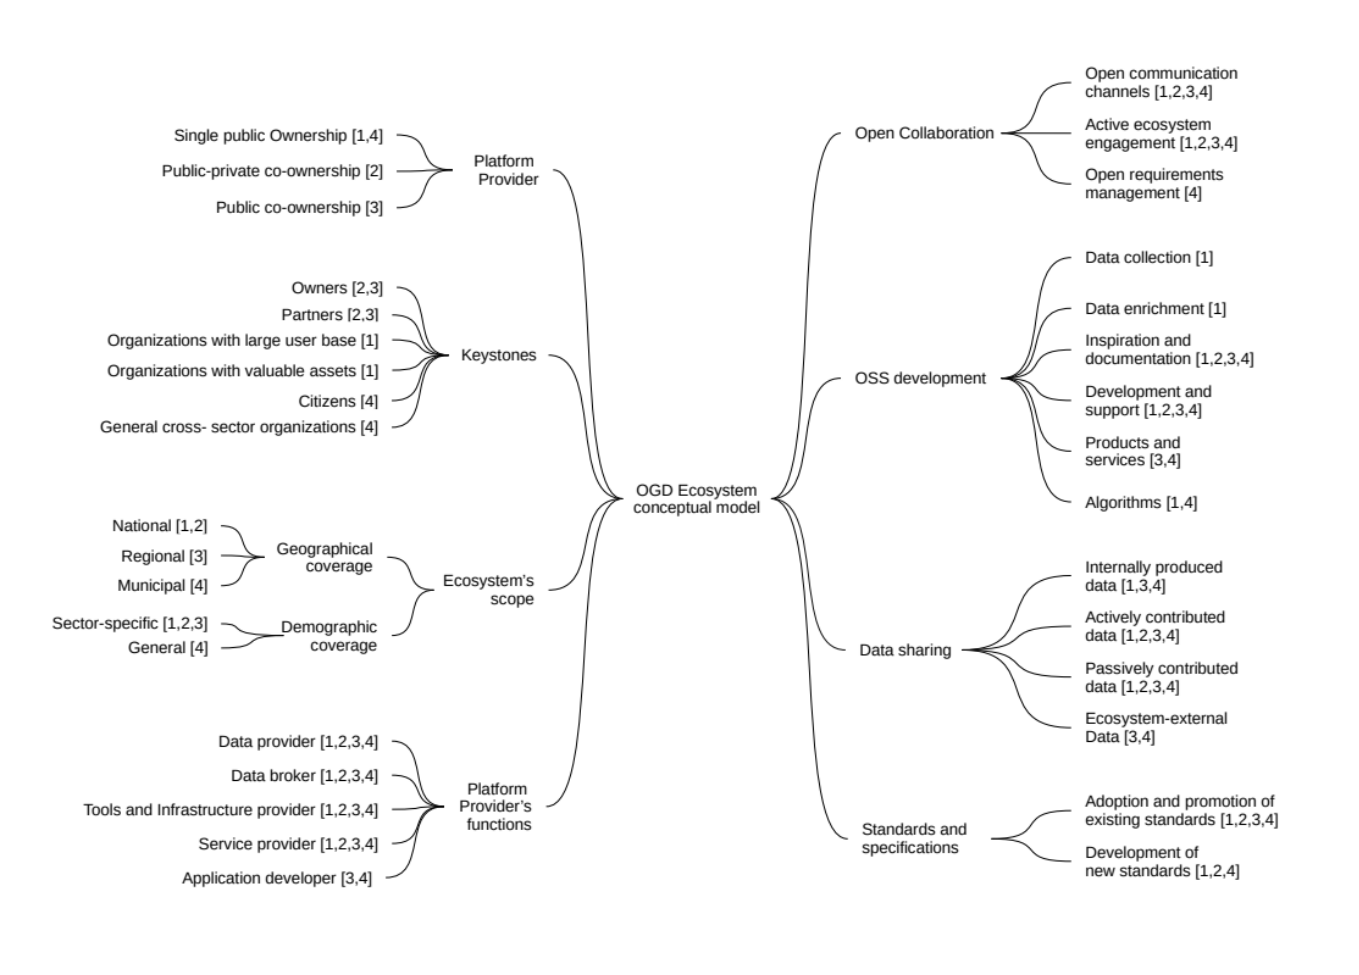
Figure 2: A conceptual model for OGD ecosystems consisting of eight main aspects and connected attributes as explained in section 5. Each attribute has the corresponding case number within brackets where it was